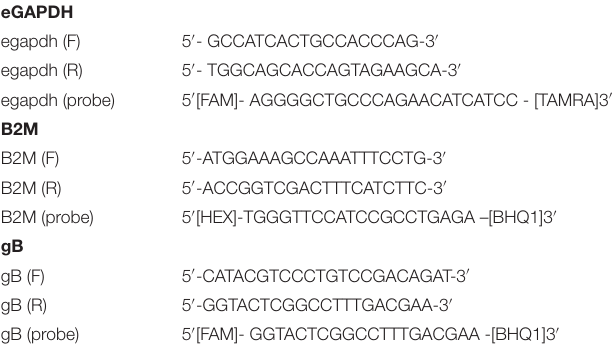
TABLE 1 | Primers and probes for qPCR used in this